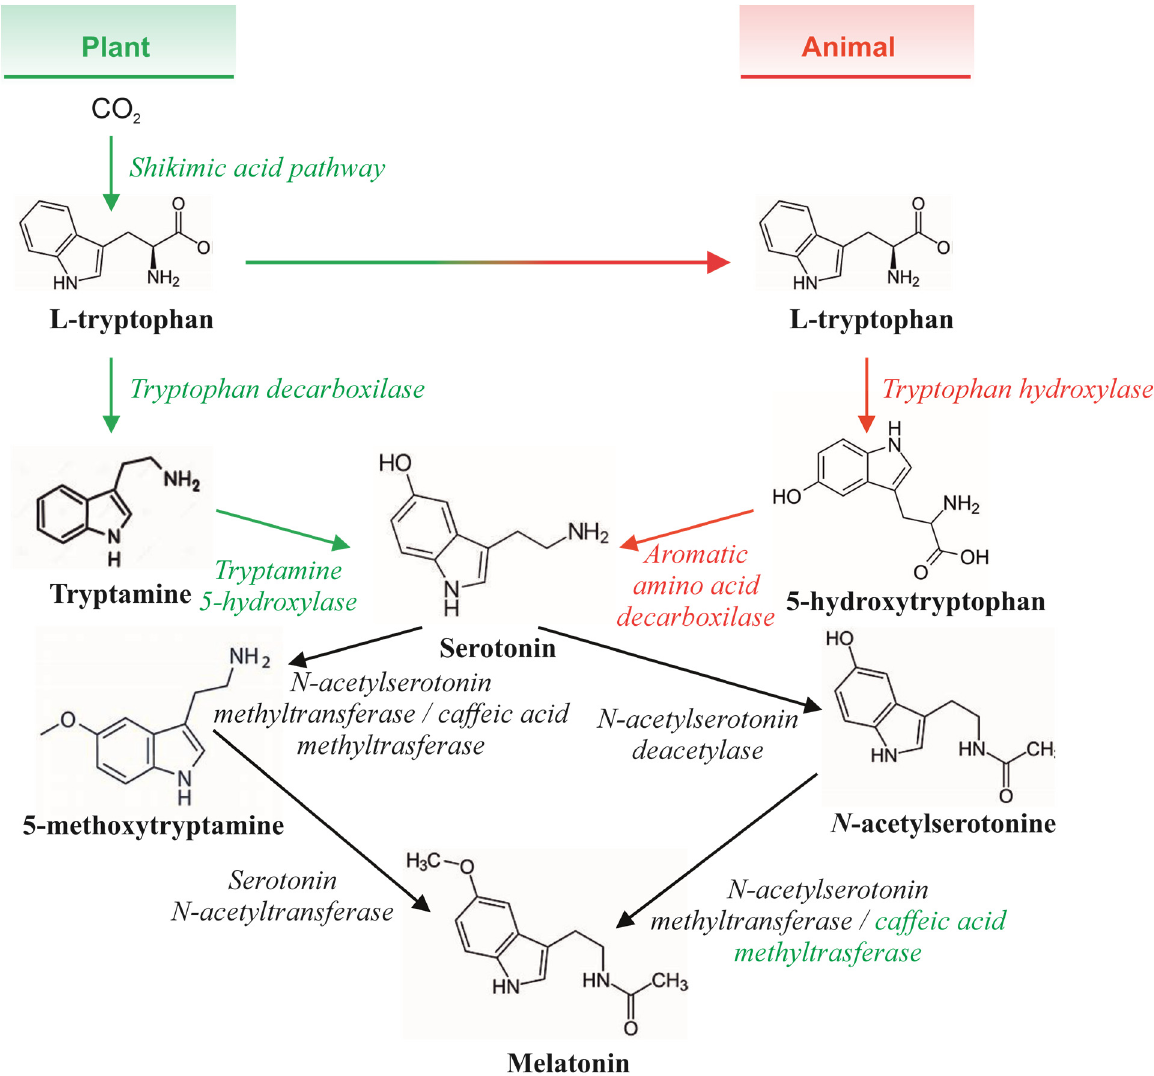
Figure 1. In humans, the essential amino acid tryptophan is used to synthesise serotonin and mela-